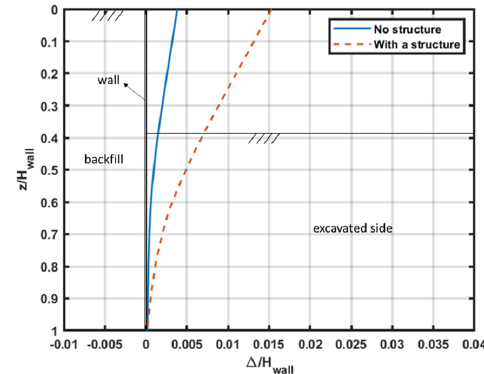
Figure 4. Static deflection of the retaining wall.